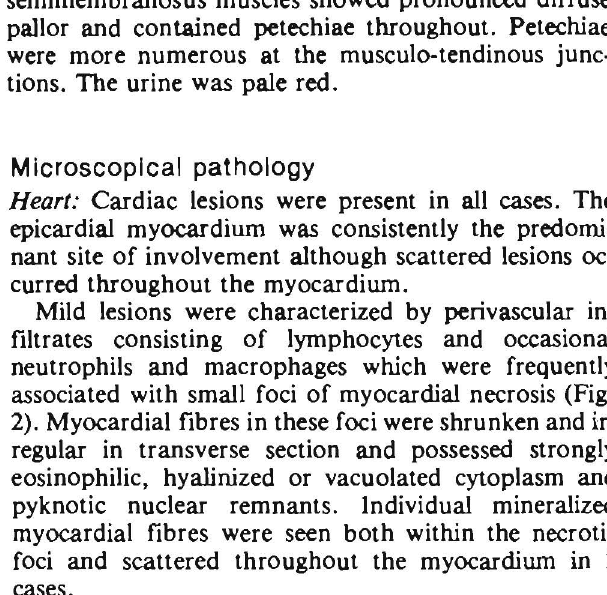
Table 1: MONENSIN CONCENTRATIONS OF THE FEED SAMPLES